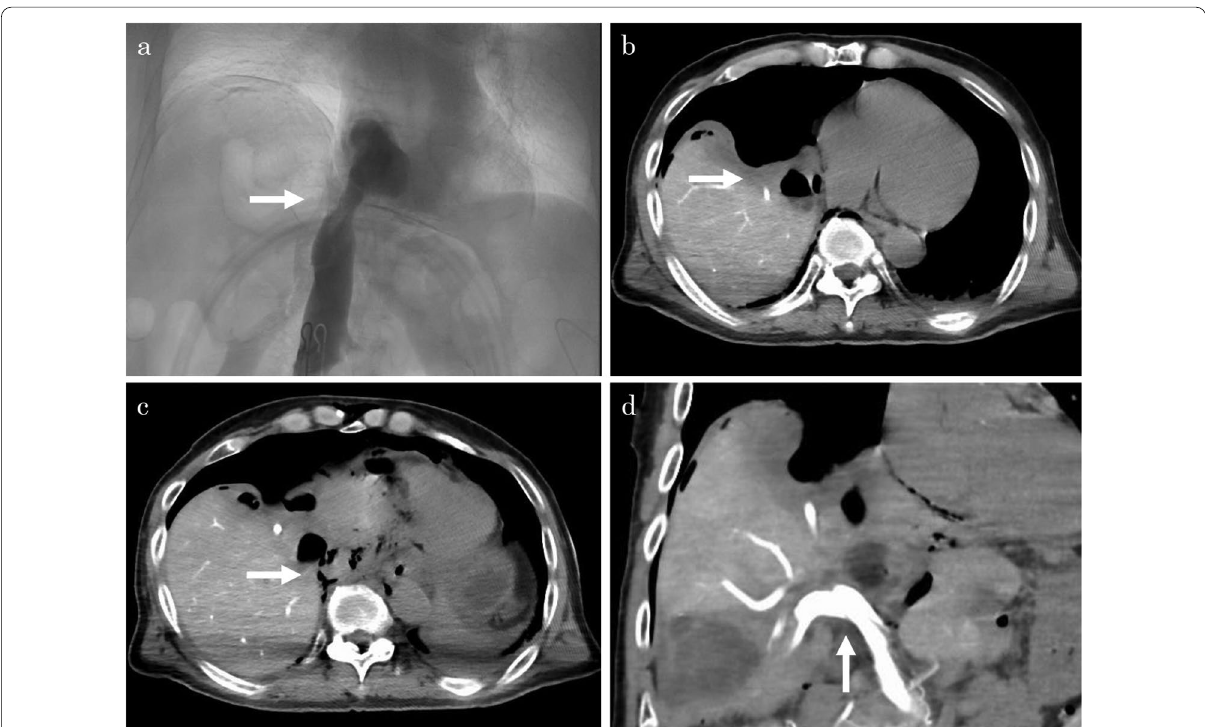
Fig. 4 Intraoperative imaging studies. Angiography confirms that the stenosis of the inferior vena cava (IVC) was resolved after cyst fenestration ( a ). Computed tomography confirms that the cysts decompressed the right heart and that cyst fenestration released the IVC stenosis ( b , c ). Computed tomography arterial portography confirms that the stenosis of the portal vein had improved ( d